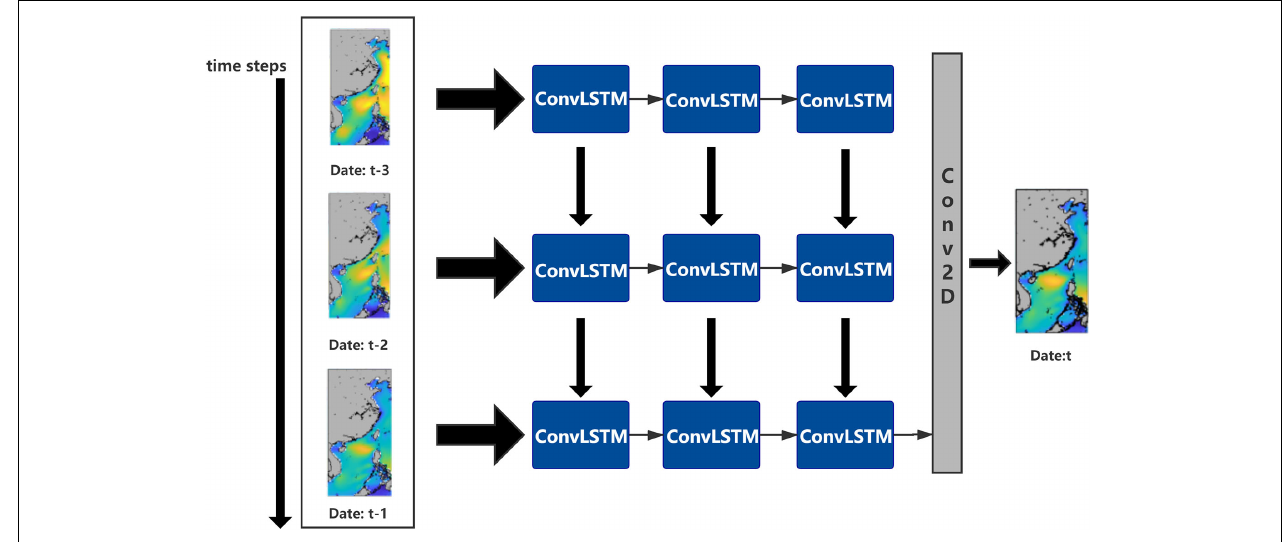
FIGURE 1 | Schematic of the SWH prediction model based on the